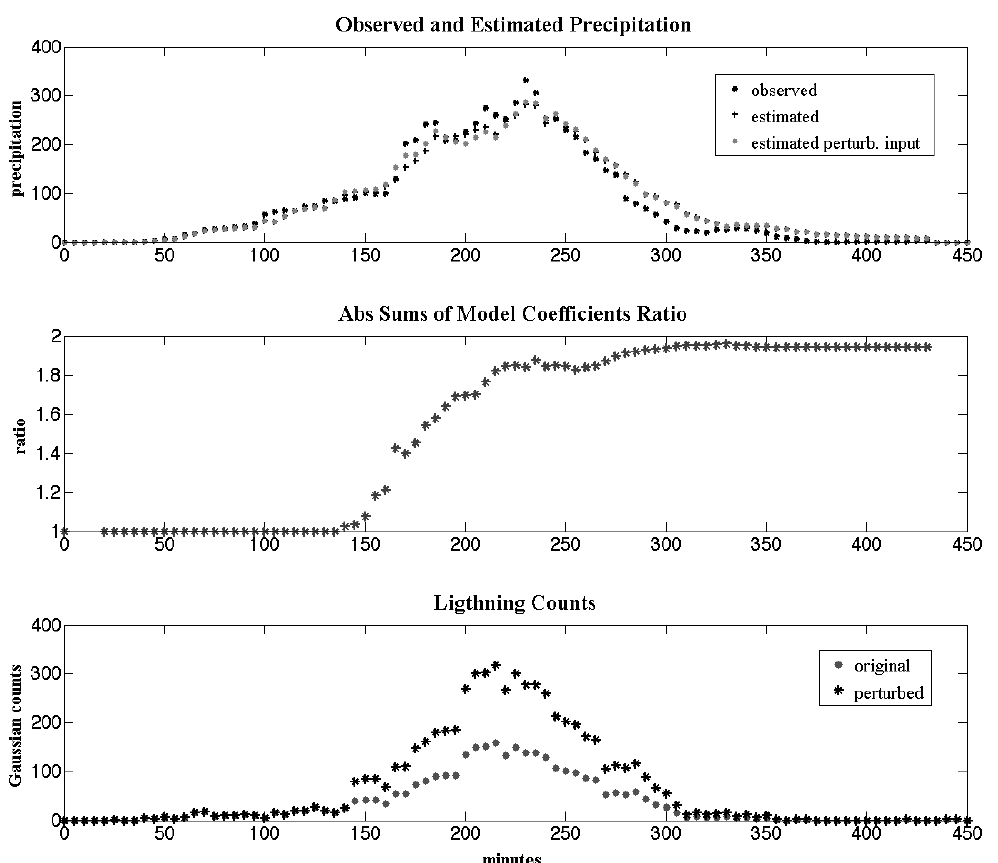
Figure 3. KMAF 2009 event on the 150th day of the year. Lightning time series (top panel), parameters ratio (middle panel) and estimated precipitation (bottom